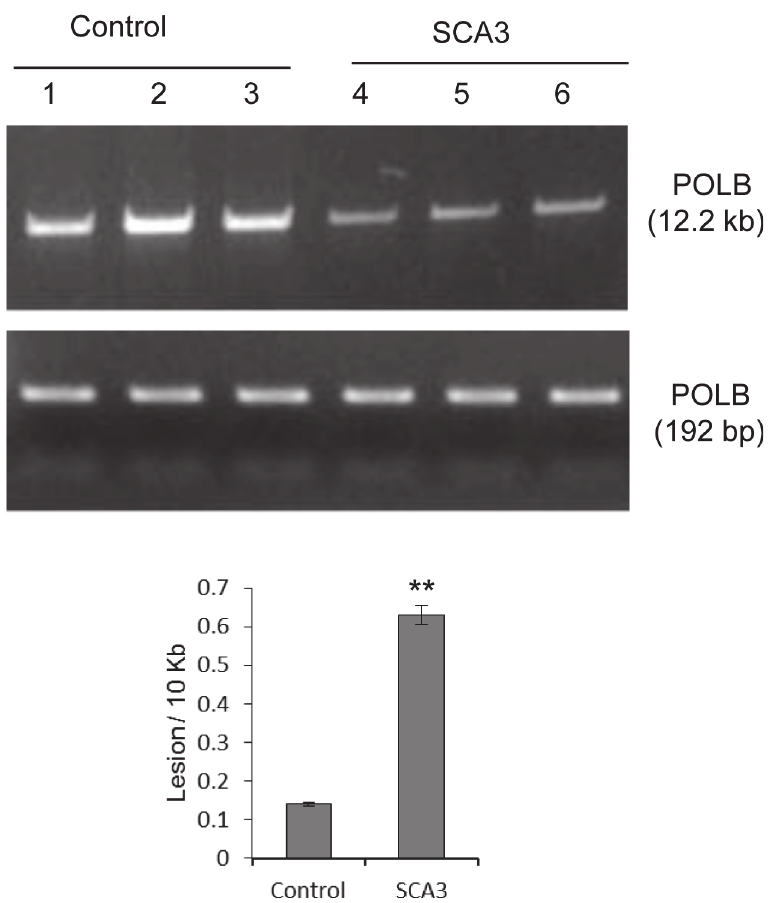
Figure 7. LA-QPCR shows increased genomic DNA damage levels in SCA3 patients ’ brain tissue. Amplification of the large fragment ( * 12 kb) of the POLB gene was normalized to the amplification product of a small fragment of the same gene. The results are expressed as DNA lesion frequency/10 Kb DNA by application of the Poisson distribution as described previously [34]. Histograms represent the DNA damage quantitation for age-matched control and SCA3 patient ’ s brain tissue (n = 3, ** = P < 0.01). Error bars indicate standard error of